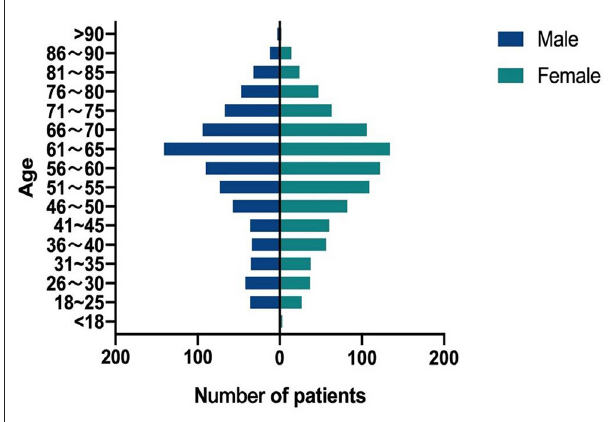
FIGURE 5 | Age and gender distribution of the patients with NTM disease during